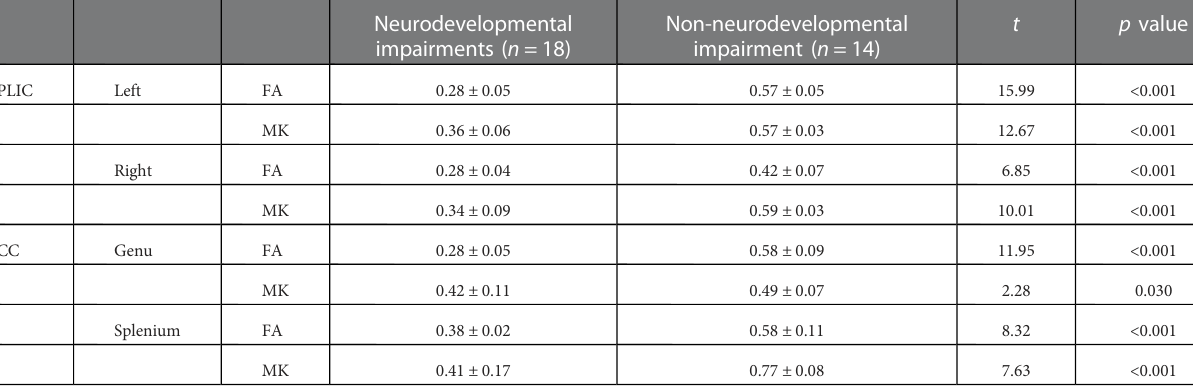
TABLE 1 Comparison of DKI parameters in PLIC and corpus callosum between two groups of neurodevelopmental impairments and non- neurodevelopmental impairments. Neurodevelopmental Non-neurodevelopmental impairments ( n = 18) impairment ( n =